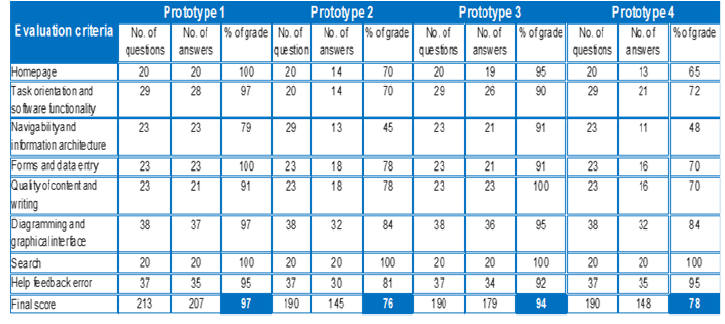
Fig. 4. Evaluation technique: Verification of the conformity of the user interface with